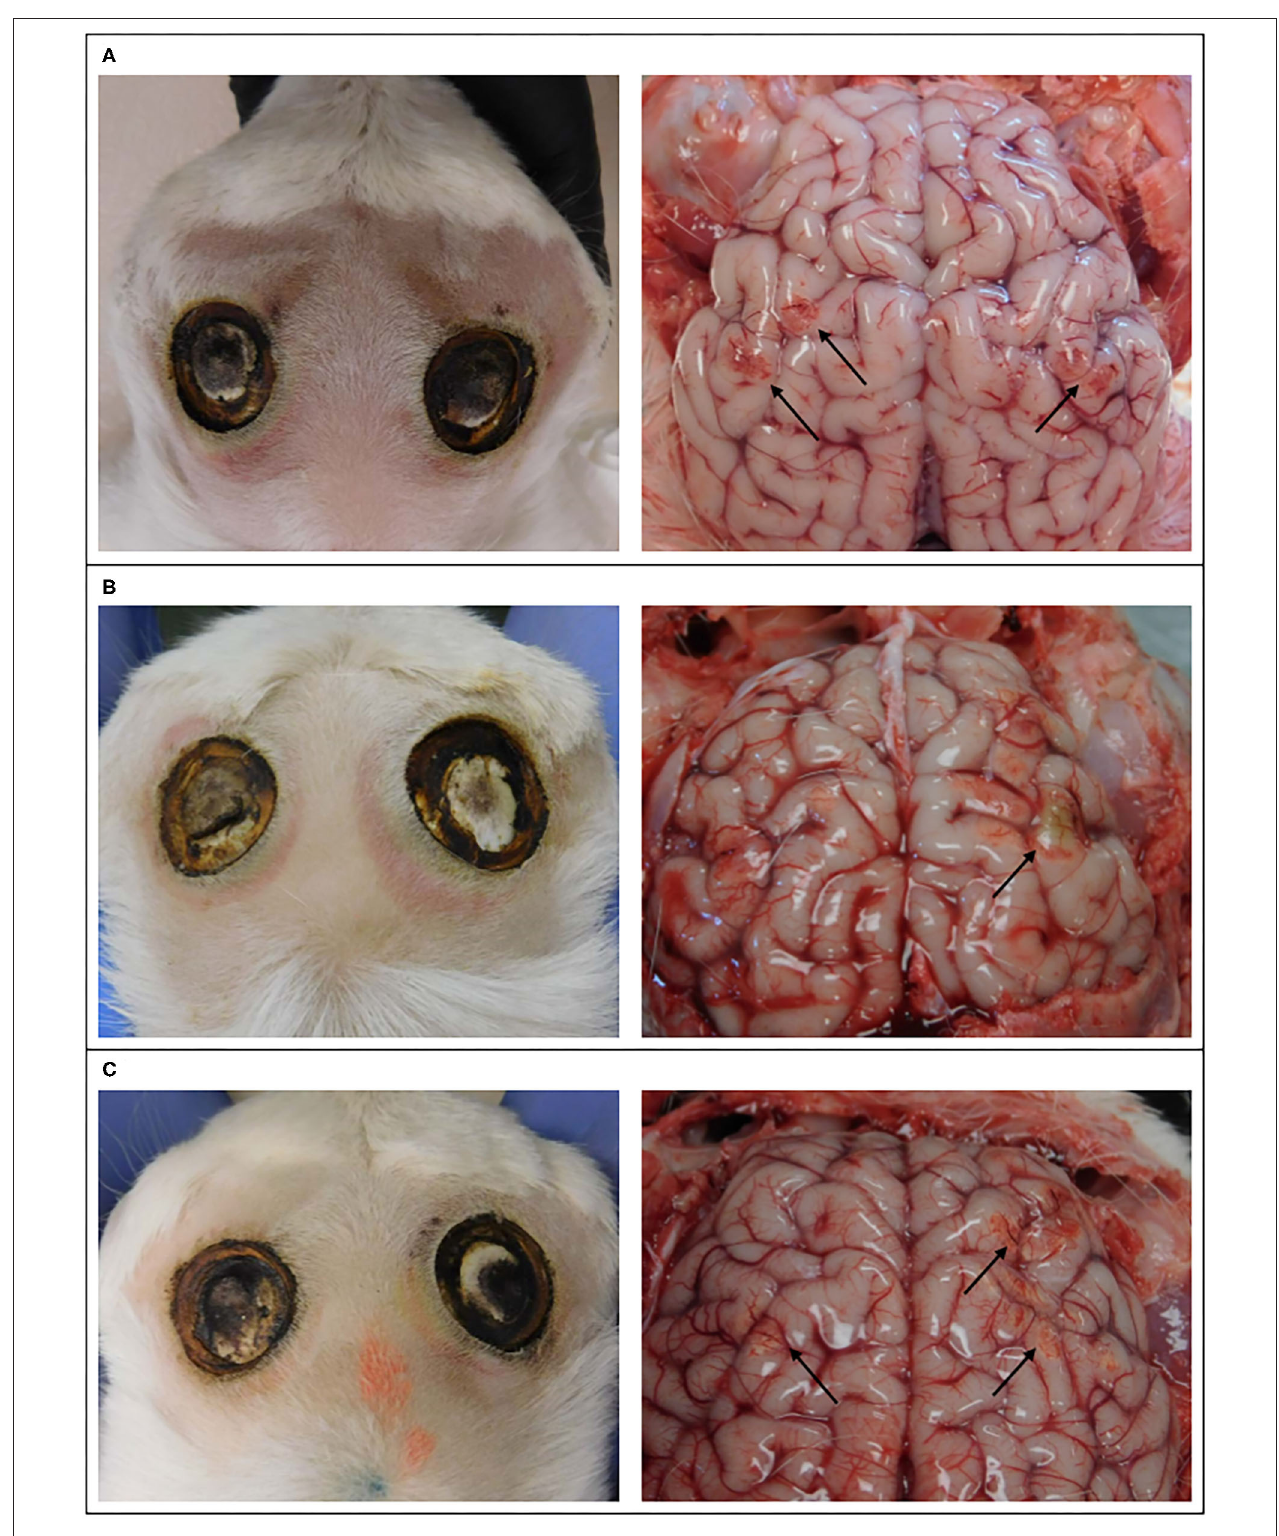
FIGURE 3 | Images of the external surface of the head of goat kids and cerebral hemispheres 4 days after cautery disbudding. These kids received 20s on left horn bud and 15s on the right horn bud (A) , 5s on the left horn bud and 20s on the right horn bud (B) , and 10s on the left horn bud and 15s on the right horn bud (C) . Arrows indicate discoloration and